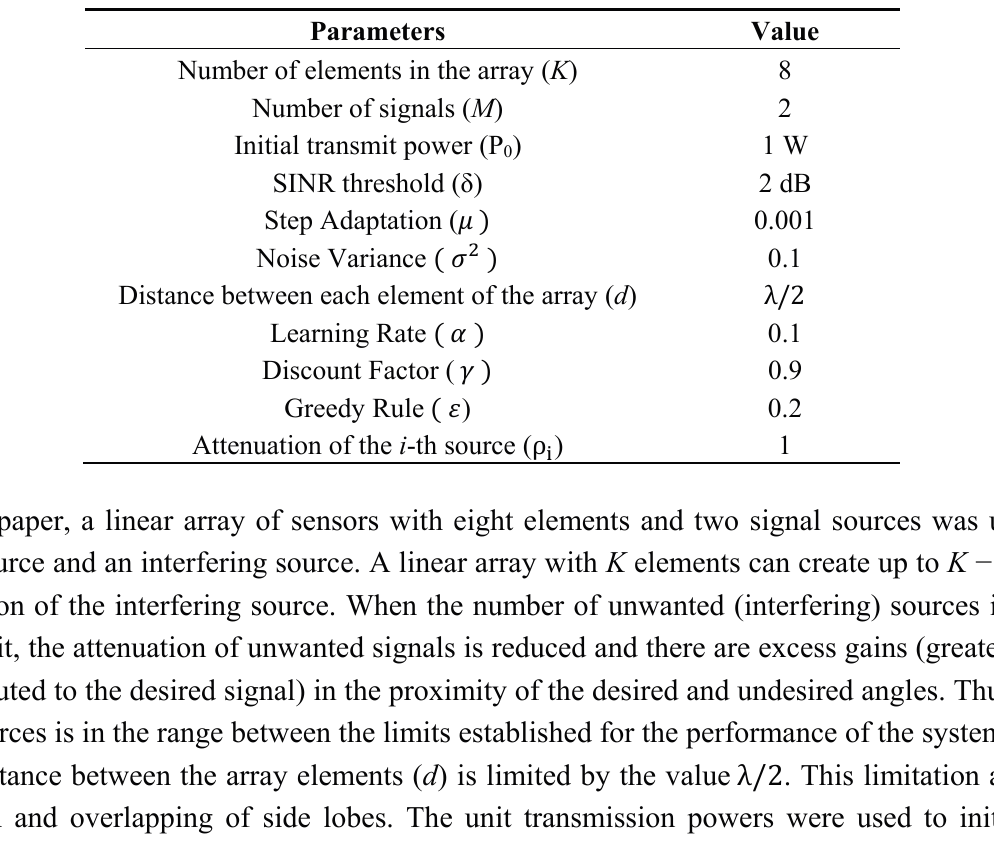
Table 1. Simulation